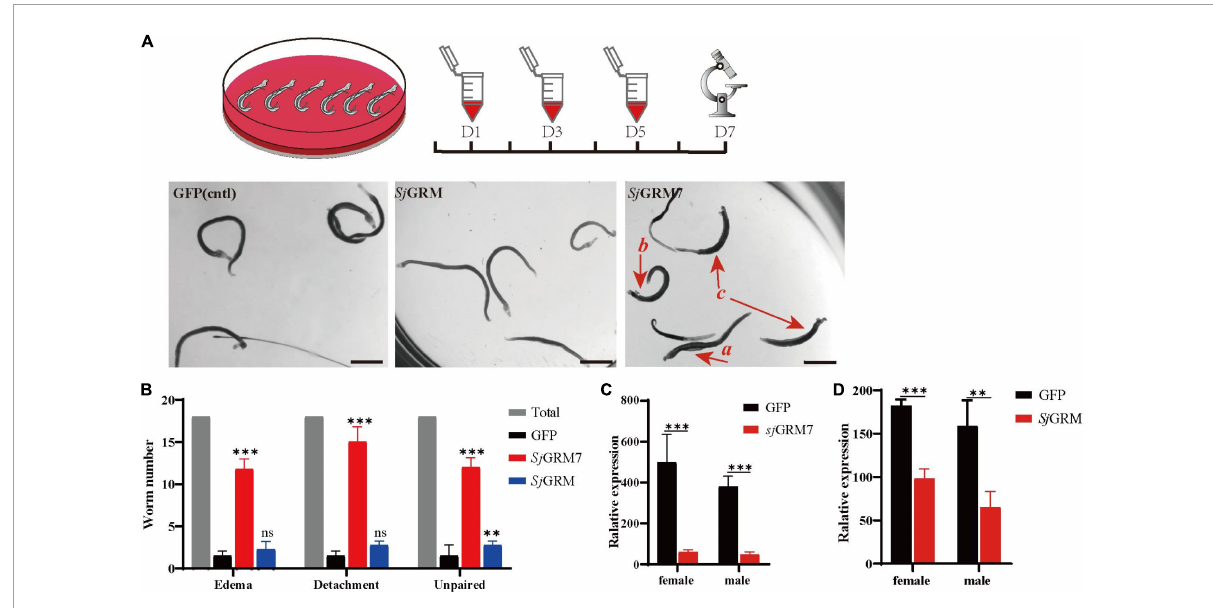
FIGURE3 Sj GRM7 is required for normal physiological activity in S. japonicum in vitro . The top is the flow chart of in vitro interference. Adults with good pairing activity were added to the petri dish, dsRNA was added for interference on the first, third, and fifth days, and microscopic observation and photography were carried out on the seventh day. Each plate had six pairs of three replicate wells for each biological experiment with four biological replicates. (A) Observation under the light microscope on the seventh day after dsRNA treatment of the control (left), Sj GRM (middle), and Sj GRM7 (right) groups. Scale bar: 200 µ m. (B) Effect statistics of the control, Sj GRM, and Sj GRM7 groups after dsRNA treatment, with the statistical indicators of swelling (detachment), no adsorption to the chassis, and unpairing. qPCR was used to detect the mRNA expression